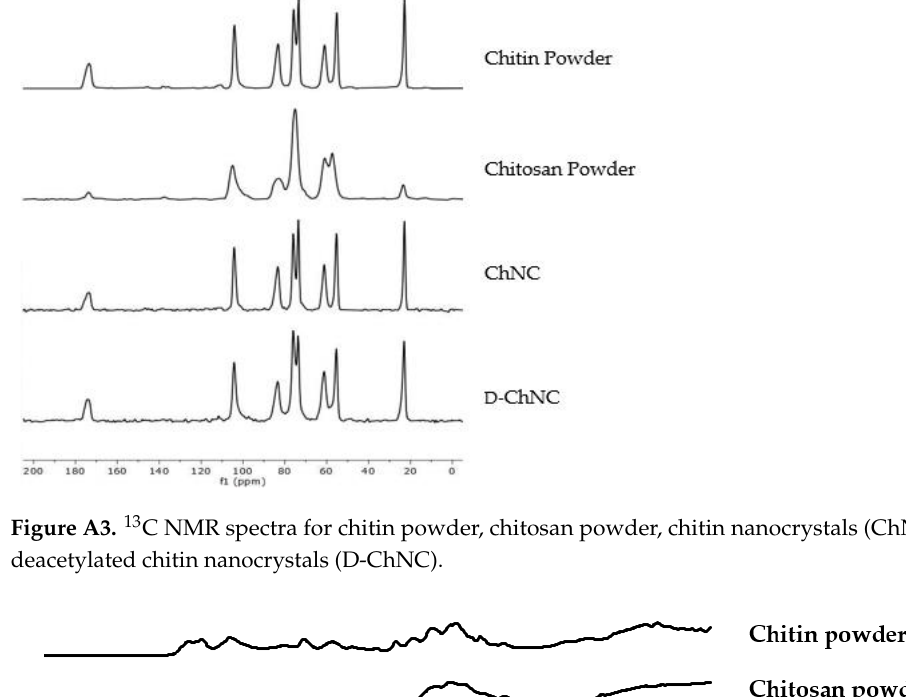
shown; error bars are indicated but mostly fall within the data points.